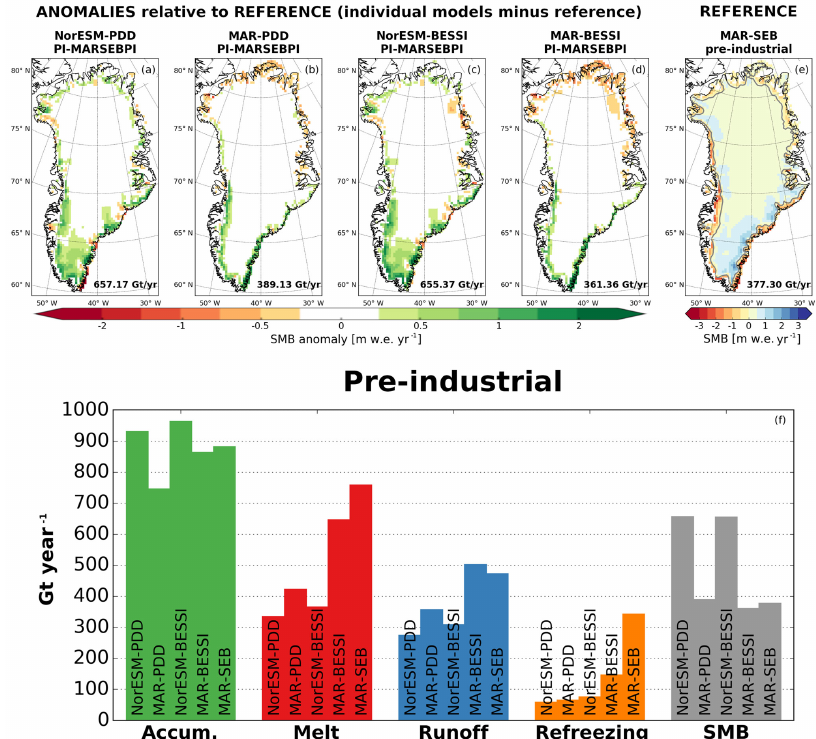
Figure 7. Comparison of the simulated pre-industrial SMB from all five model setups. The first row shows the spatial map of SMB for NorESM-PDD, MAR-PDD, NorESM-BESSI, MAR-BESSI, and MAR-SEB, respectively. Our reference, MAR-SEB (e) , is shown in ab- solute values, while the four simpler models (a–d) are shown as anomalies to MAR-SEB. The total SMB integrated over all of Greenland (including grid cells with more than 50% permanent ice) is given in numbers on each panel. The same ice mask is used for the bar plots (f) . The bar plots show the individual components contributing to the total SMB (in Gtyr − 1 ) for each